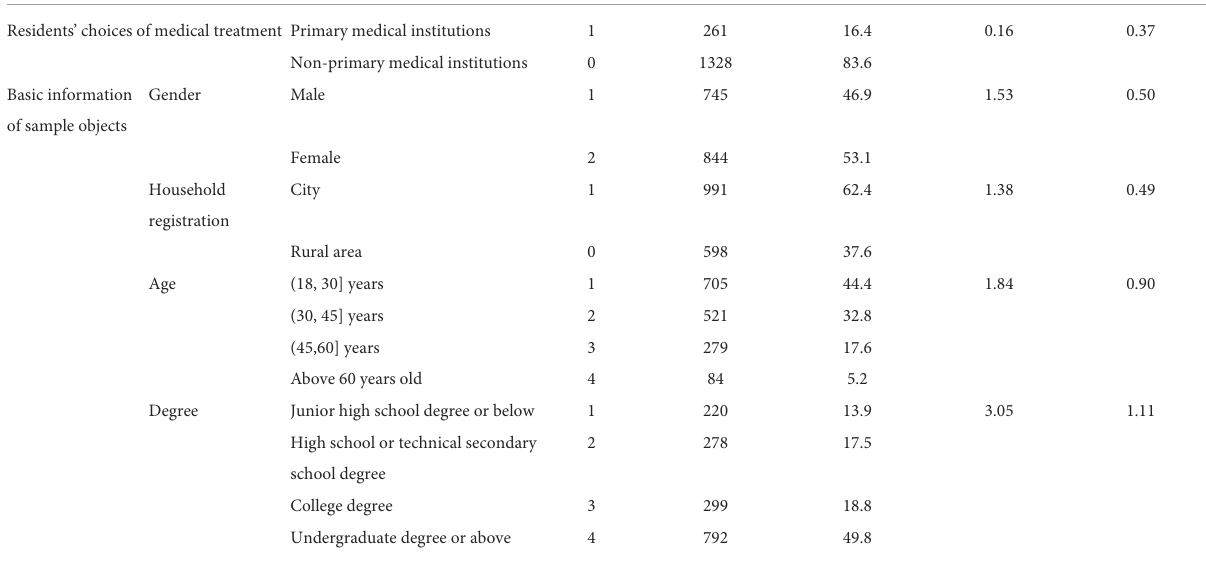
TABLE 2 Basic information of sample